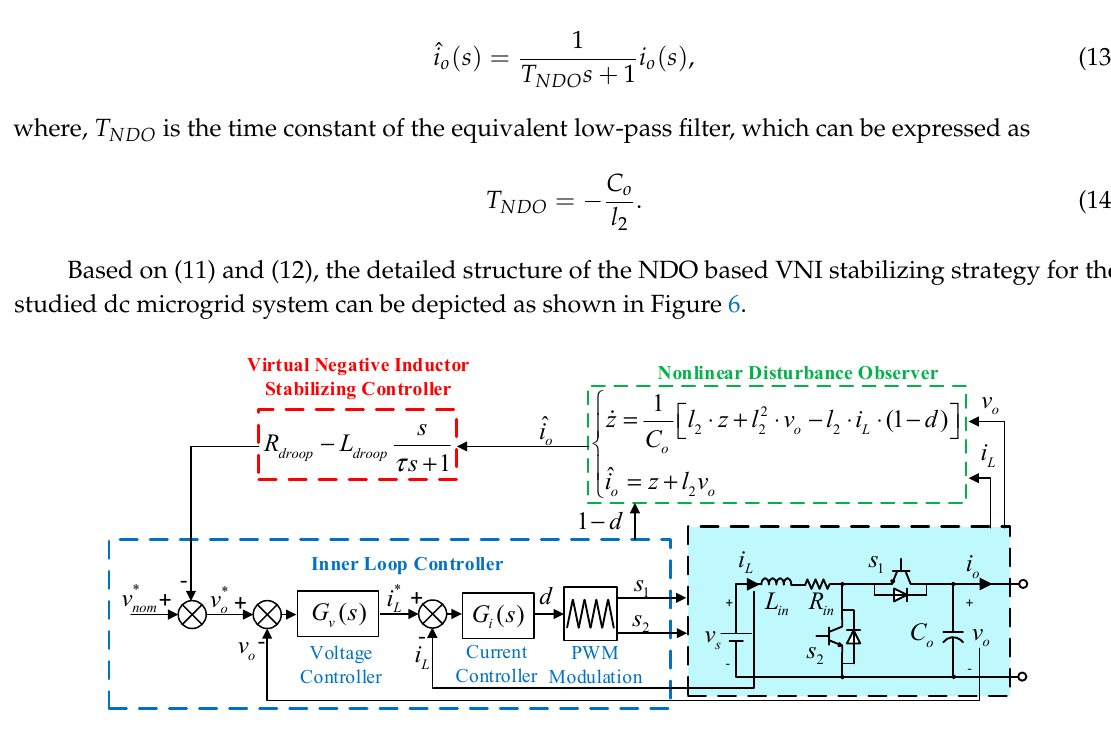
Figure 6. Detailed structure of NDO based VNI stabilizing strategy.